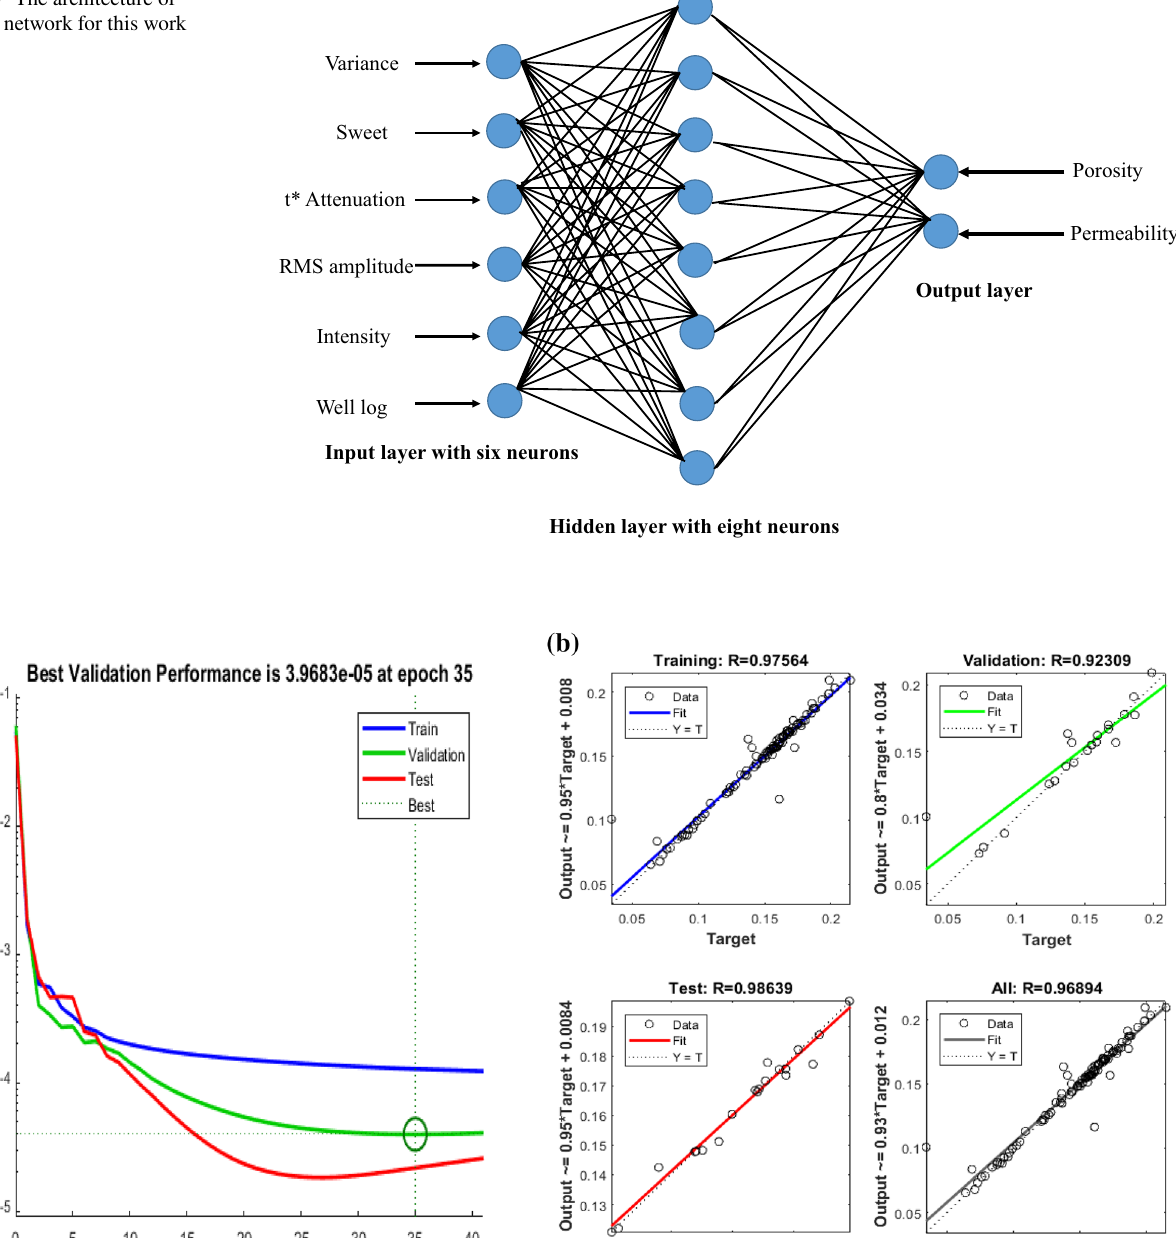
Fig. 10 The architecture of neural network for this work